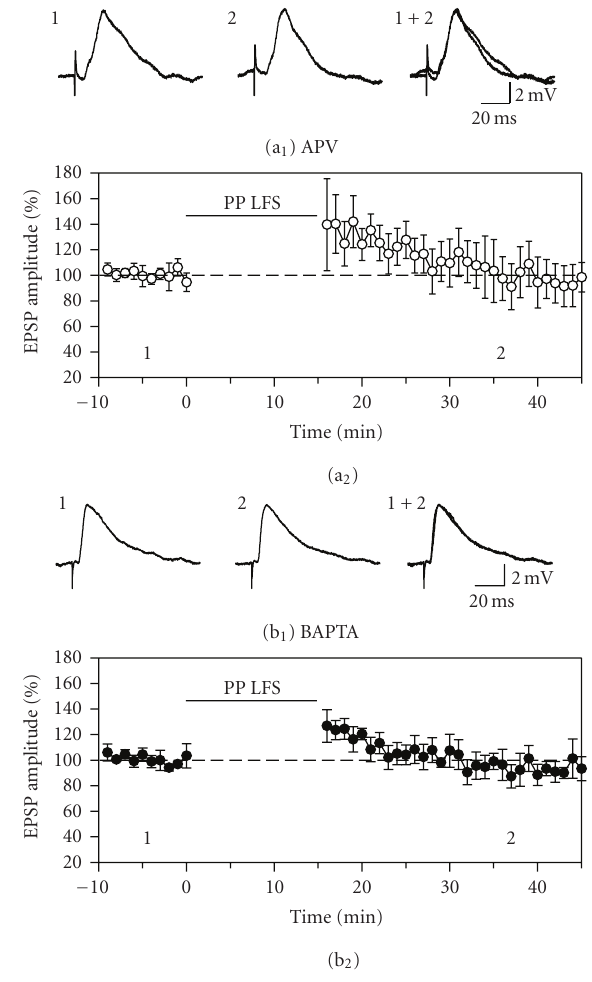
Figure 2: The induction of long-term depression is dependent on activation of NMDA glutamate receptors and on increases in postsynaptic calcium. (a) Constant bath application of the NMDA receptor antagonist APV (50 μ M) blocked the induction of long- term depression by 15 minutes of paired-pulse low-frequency stimulation (PP LFS). (b) Blocking increases in postsynaptic calcium by including the calcium chelator BAPTA (10mM) in the recording electrode solution also blocked the induction of LTD. The transient facilitation of EPSPs immediately following stimulation was significant for the BAPTA condition but not the APV condition, and responses were at baseline levels at the end of the recording periods. The block of lasting depression suggests that calcium influx via NMDA receptors is required for induction of